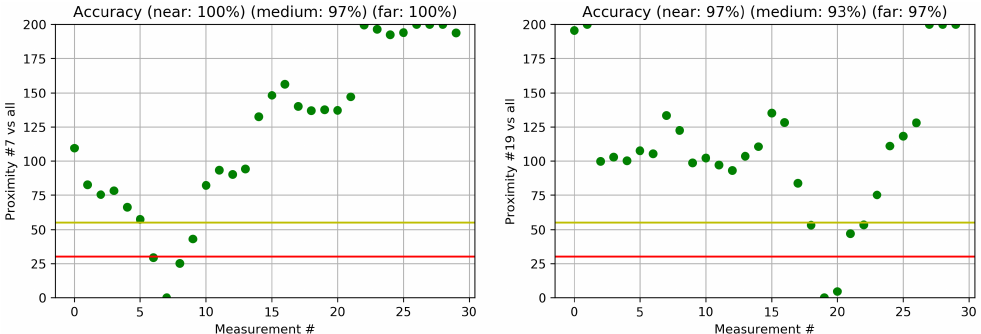
Figure 5. Proximity for indoor measurements. The red and yellow lines are thresholds T1 and T2, and green dots denote proximity to location #7 ( left ) and #19 ( right